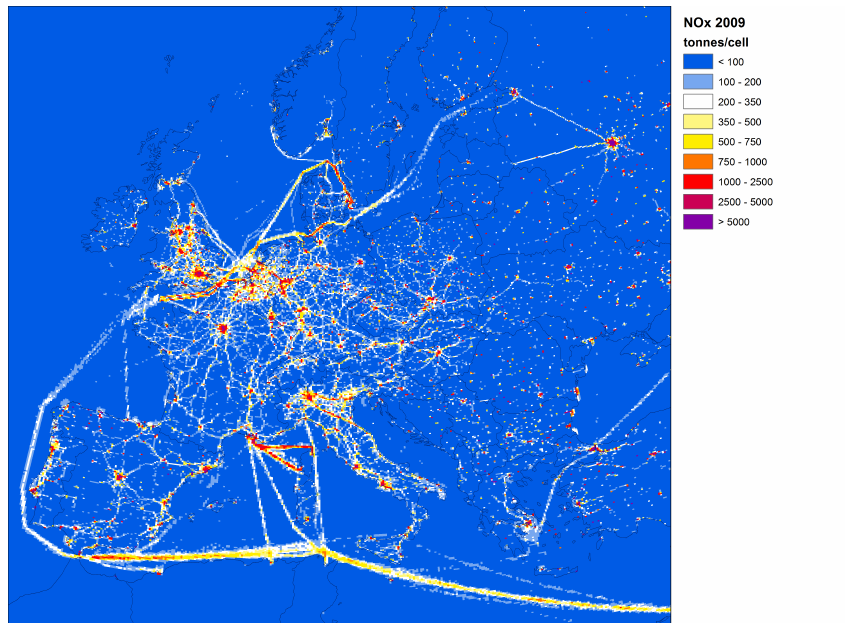
Figure 8. Spatially distributed NO x emissions from the year 2009 for all